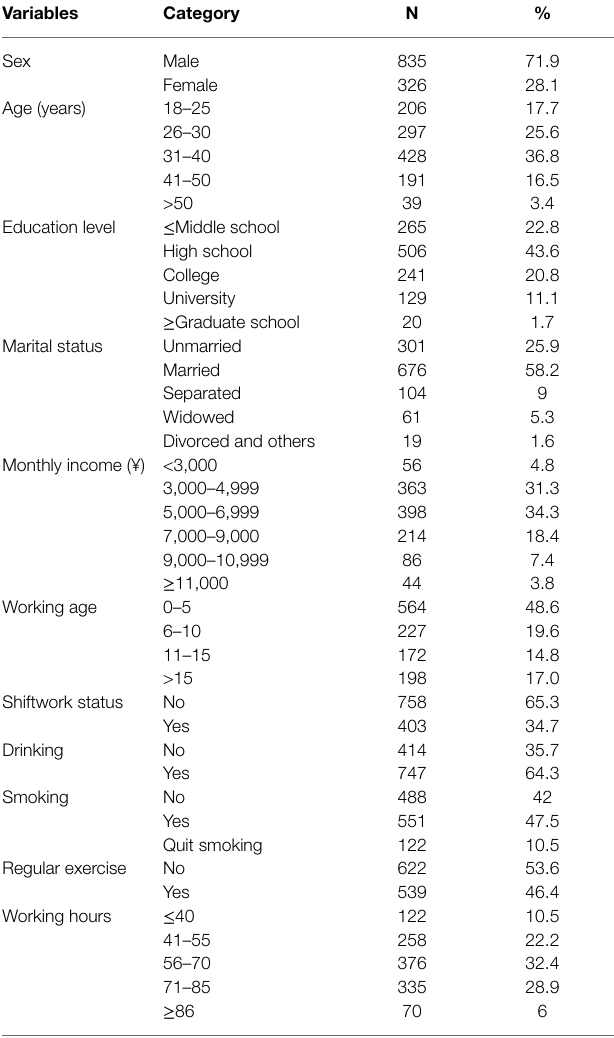
TABLE 1 | Characteristics of participants.